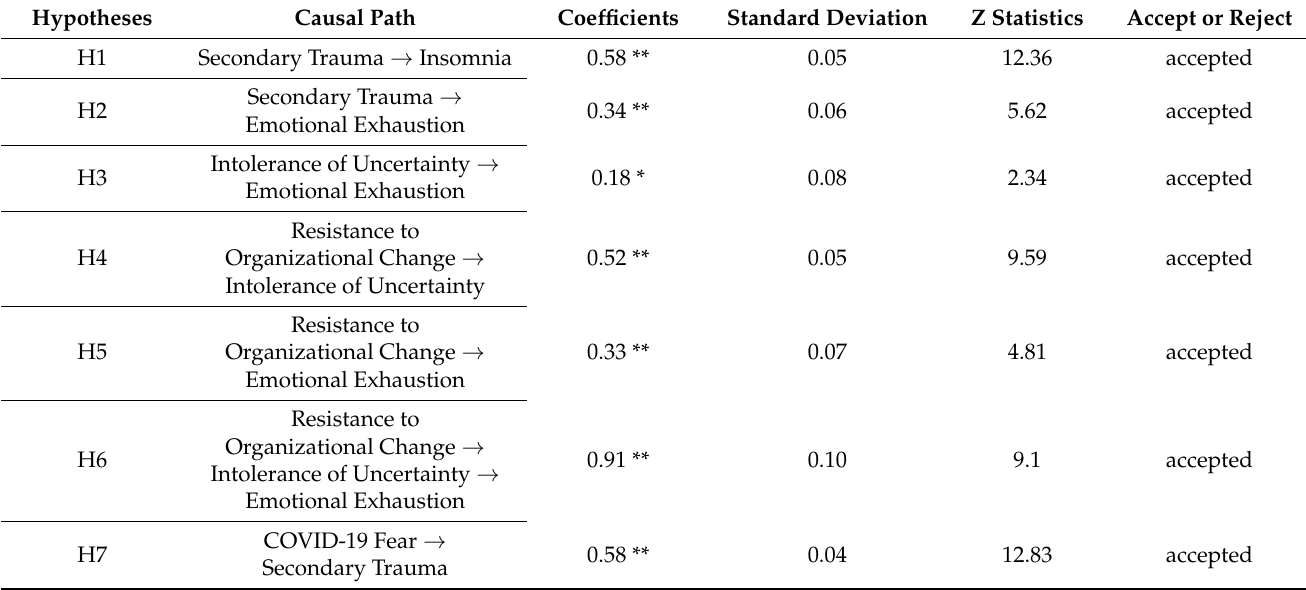
Table 4. Path coefficients (coefficients, STDEV, t -values).